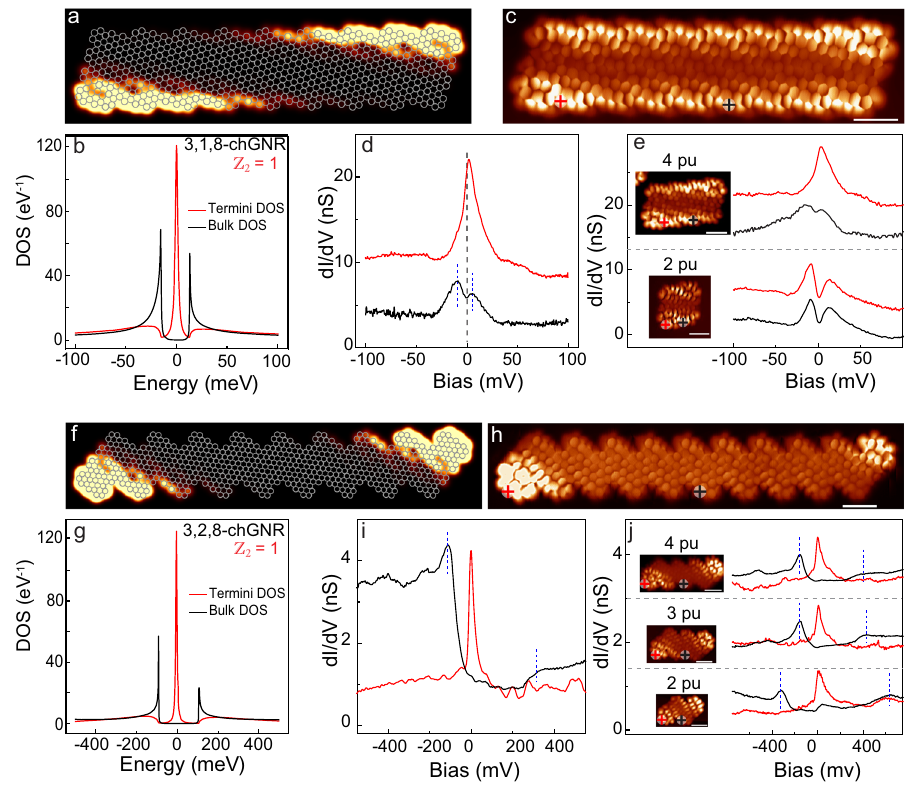
Fig. 5 SPT boundary states of 3,1,8- and 3,2,8-chGNRs. a, f Zero-energy LDOS distribution of fi nite 3,1,8-chGNRs and 3,2,8-chGNRs of 9 precursor units obtained with TB simulations and, b, g their corresponding Density of States (DOS) over the center (bulk) and the termini surface showing the localization of zero-energy boundary states. c, h Constant height dI / dV maps ( V = 0 mV) of 3,1,8-chGNRs and 3,2,8-chGNRs with 9 and 10 precursor units respectively and, d, i dI / dV spectra taken over the termini and edge ’ s center (as indicated with colored crosses). Scale bar amounts to 1 nm. e, j Comparison of dI / dV spectra taken on the termini and on center of short ribbons con fi rm the survival of topological states in ribbons as small as 4 and 2 precursor units for the 3,1,8- and 3,2,8-chGNR, respectively. Insets show constant height dI / dV maps (V = 0 mV). Spectra in d, e, j are shifted for clarity. Blue dashed lines in d, e, i, j indicate the VB and CB onset